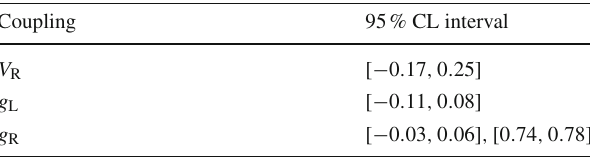
The correct limits on the anomalous couplings (Table 5) and the corresponding plots (Fig. 6a, b) are: Table 5 Allowed ranges for the anomalous coulings V R , g L , and g R at 95%CL.Thelimitsarederivedusingthemeasured W helicityfractions using the leptonic analyser for events with ≥ 2 b -tags (combination of the two channels, electron and